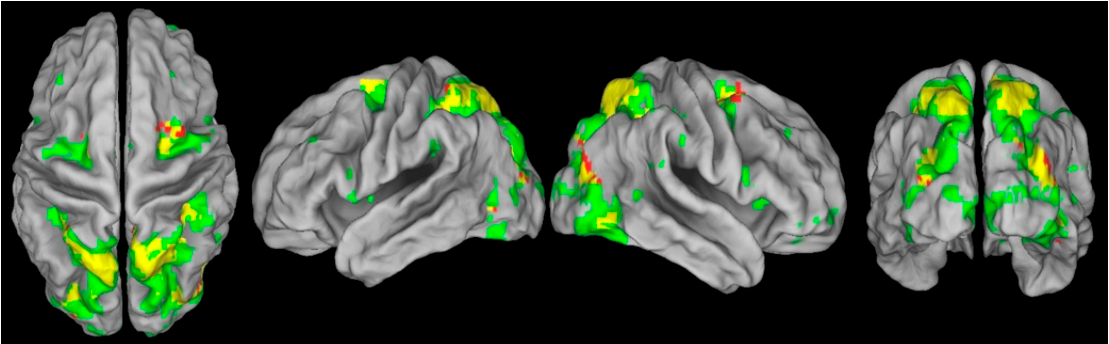
Figure 1. In red are the areas of the brain that are significantly activated in the covert shift of attention task and in green the areas of the brain significantly activated in the overt shift of attention task. In yellow are the areas of the brain activated in both the overt and the covert shift of attention task. Reproduced with permission from [24] .